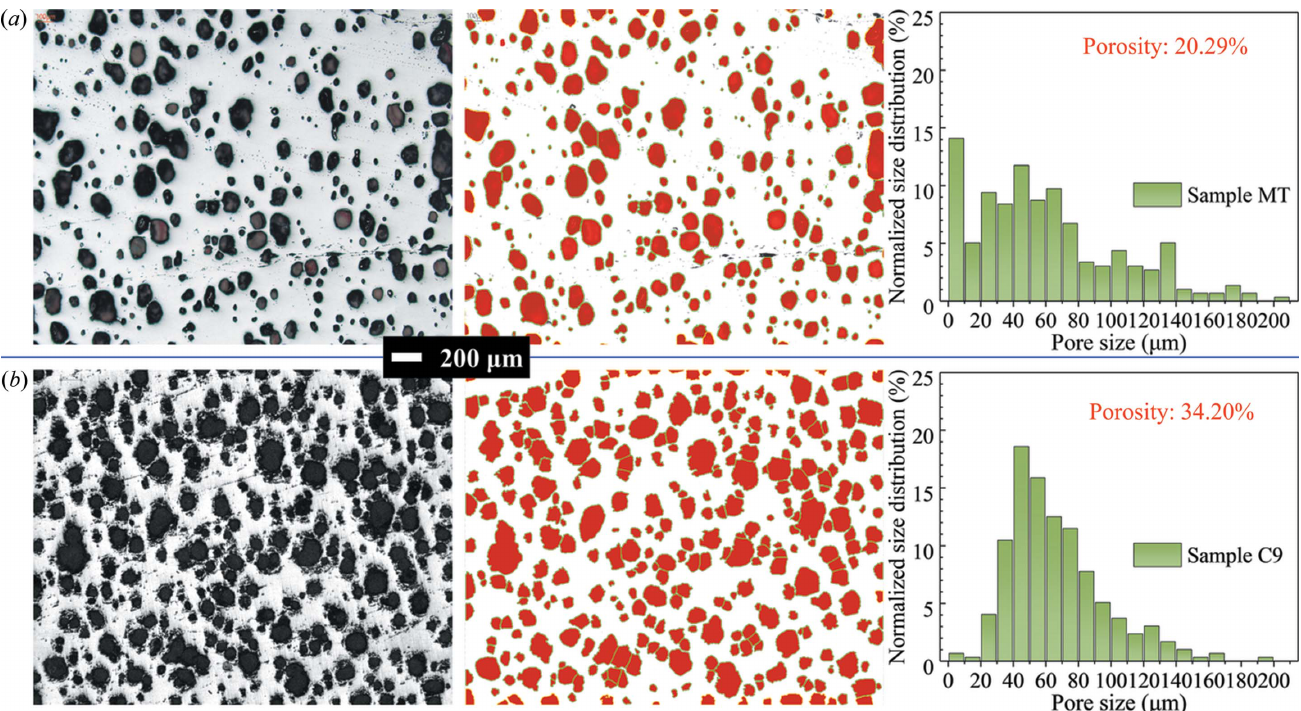
Figure 8 Optical micrographs (both taken at the centres of the ac planes), processed images by ImageJ and normalized pore-size distributions with porosities of YBCO crystals grown under different conditions: ( a ) MPP with a T-seed, ( b ) CPP with a 9 (cid:5) 9 mm